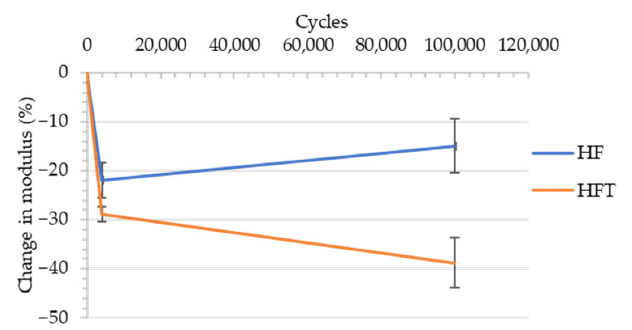
Figure 17. Modulus drop for hybrid HF and HFT composites after 4000 and 100,000 cycles at 70% maximum flexural strength.